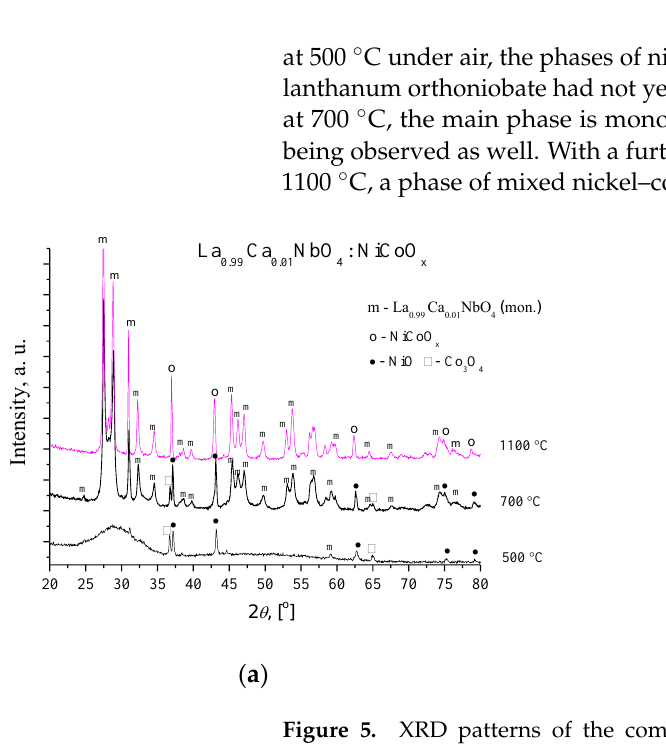
( b ) Figure 4. TEM images of ( a ) NiCo and ( b ) NiCu after calcination at 500 °C.